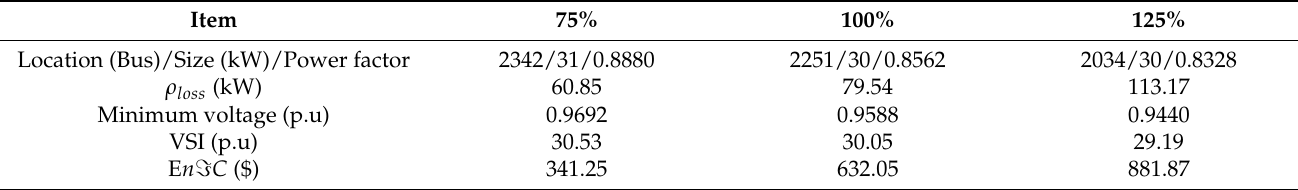
Table 7. Results of 33-bus network for different load cases on SMM